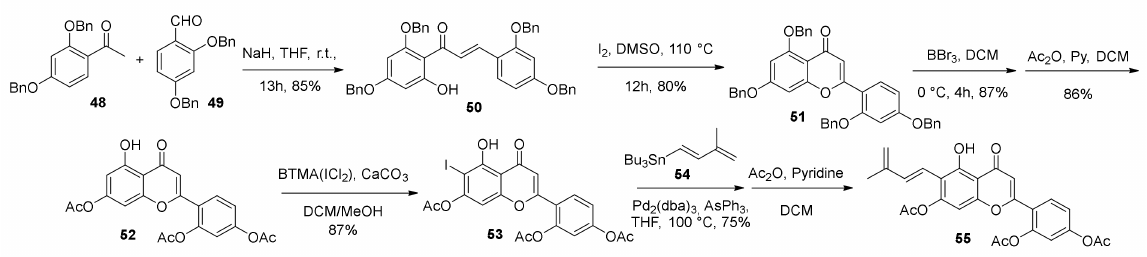
Figure 16. Chemical synthesis of key flavonoid diene 55